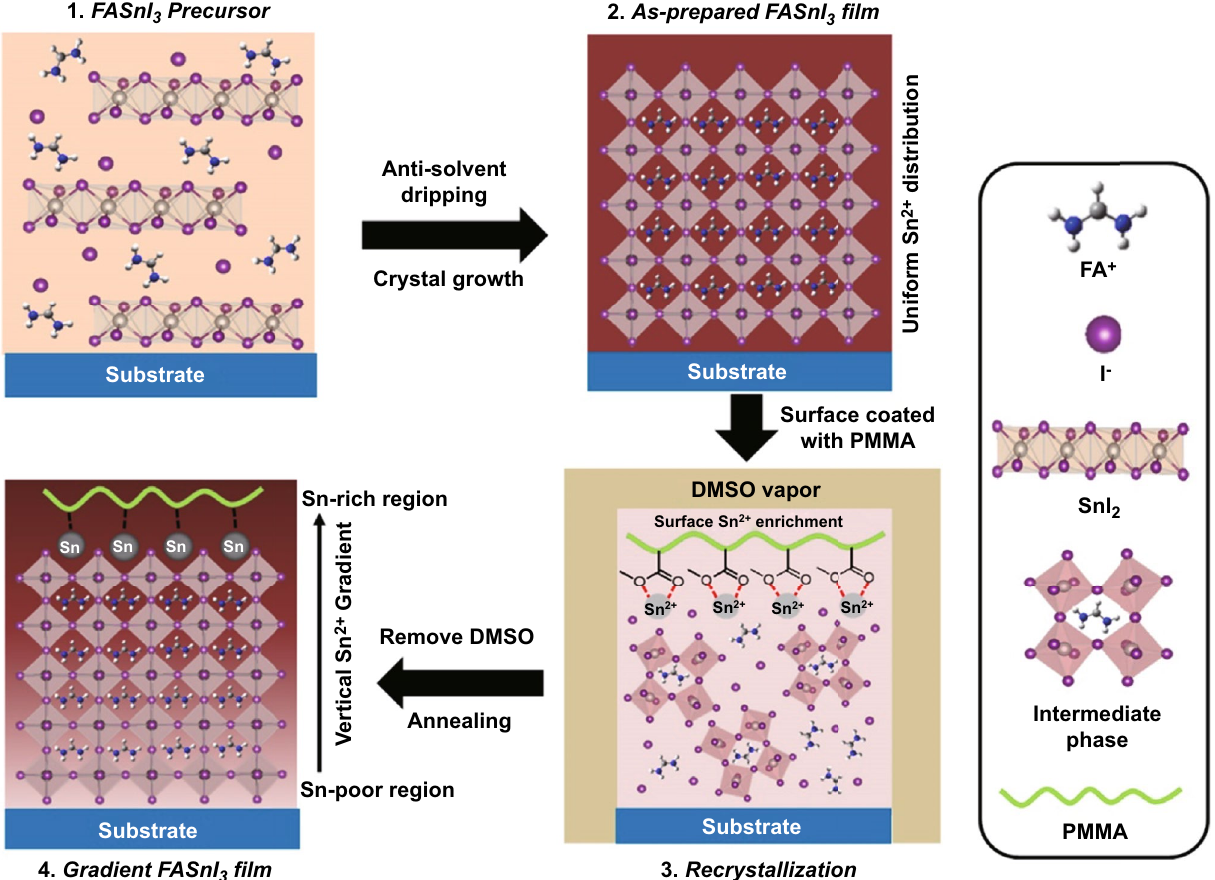
Fig. 1 Schematic of the fabrication of gradient FASnI 3 film with an increased Sn 2+ content from bottom to top by recrystallization of the as- prepared FASnI 3 perovskite film assisted with surface-coated PMMA with a high concentration of carboxylate